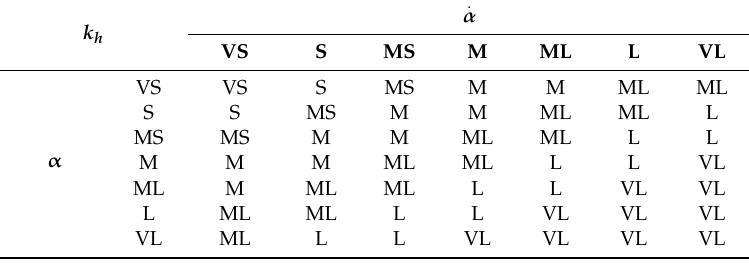
Table 8. Fuzzy control rules of target hydraulic braking torque change rate.